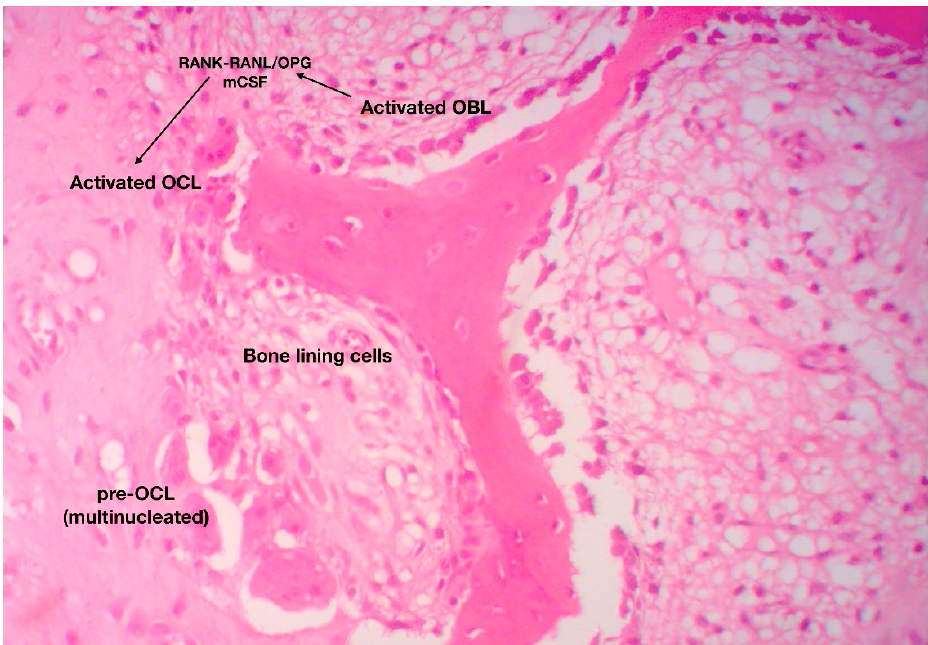
Figure 6. The catabolic phase of fracture-healing is characterized by reshaping of the hard (boney) callus. The RANK-RANKL axis has a central role in the differentiation, maturation and activation of bone-resorbing osteoclasts (original magnification 10×).